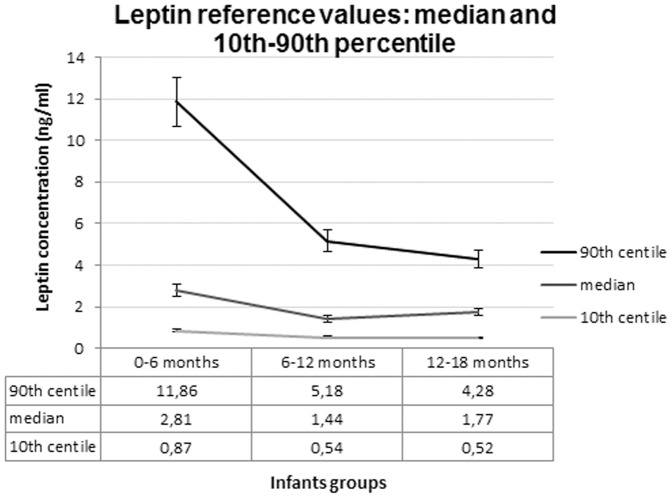
Reference serum leptin concentrations in healthy infants: median and 10th–90th centile (Error Bars 10%).(Source: self-elaborated).